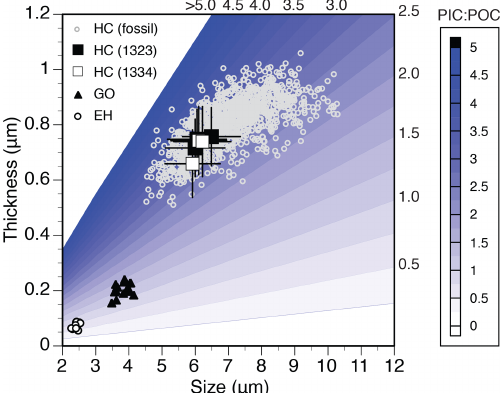
Figure 8. Helicosphaera carteri (HC) coccolith dimensions in cul- ture (black squares; mean ± 1SD) and fossil samples (grey circles; individual measurements at DSDP Site 525, N = 1156) overlaid onto empirical relationship between coccolith size, coccolith thick- ness and PIC:POC (contours) based on culture data of E. huxleyi (EH) and G. oceanica (GO; McClelland et al.,